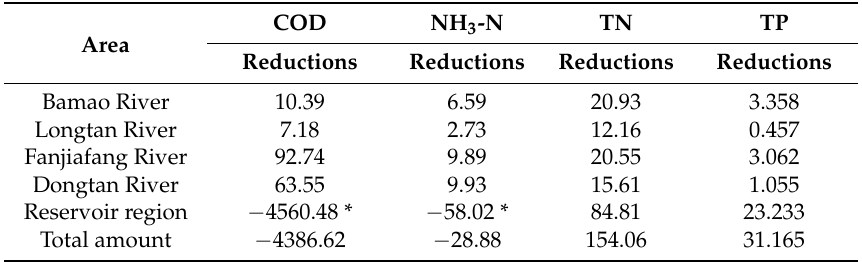
Table 12. The pollutants reduction targets of the Huangshi Reservoir in 2020 (units: tons/year). COD Area